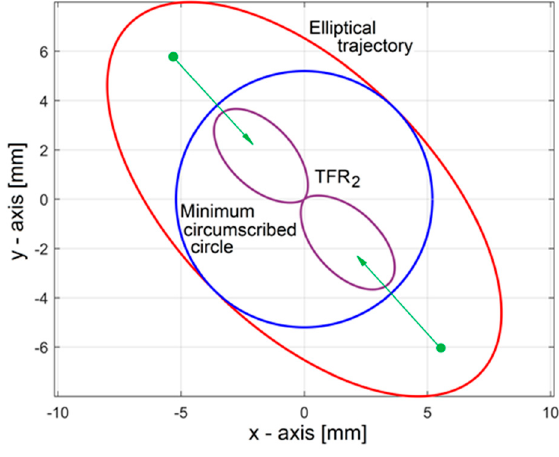
Figure 17. The evolution of TFR 2 generated by circular fitting on an elliptical trajectory (simulation). The least square circle (14.2 μ m radius, with center at x c = − 3.3 μ m and y c = − 1.9 μ m)